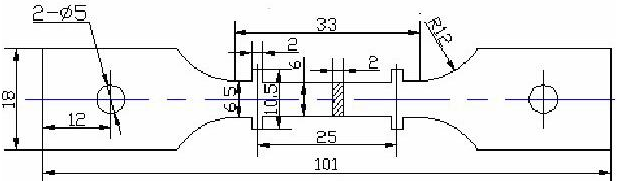
Figure 1. The geometric dimensions of tensile creep samples [18].